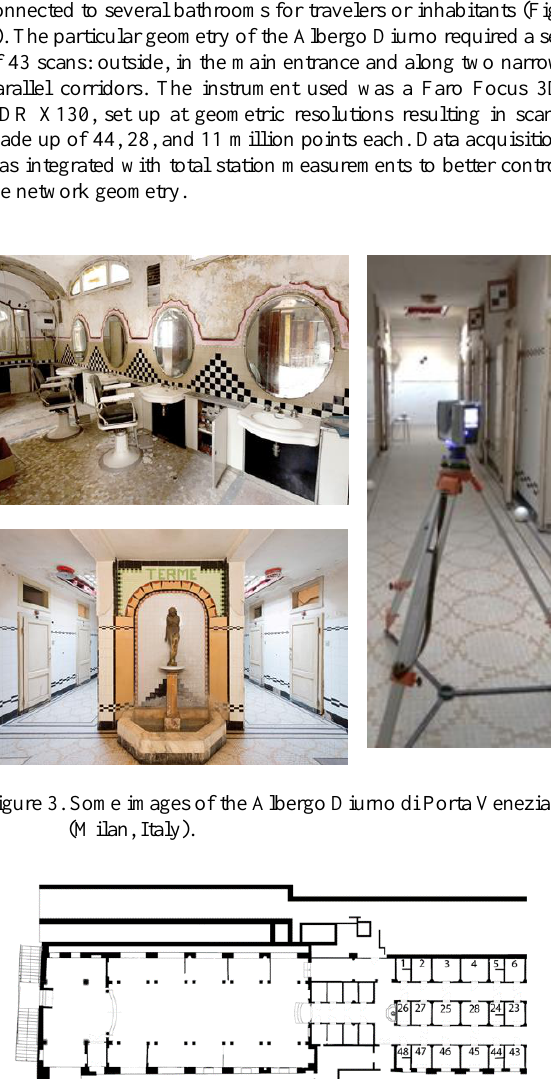
Figure 4. Planimetric view of the Albergo Diurno di Porta